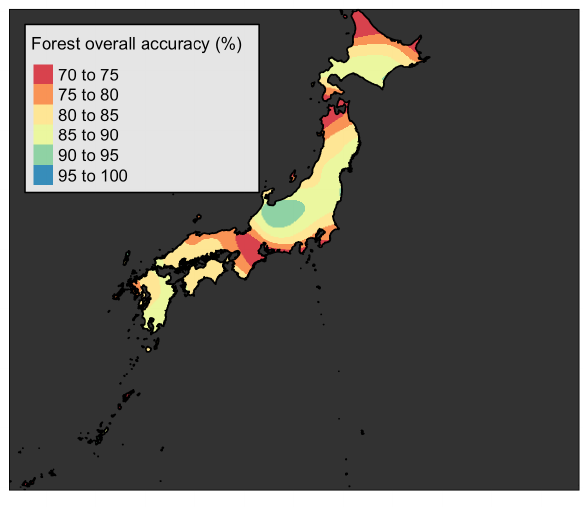
Figure 2. Geographically weighted forest overall accuracy. Maps of both GWFU and GWFP shown in Figure 3 and 4 demonstrate clear spatial variations of accuracy. The highest variation can be found in the EBF for both of the FU and the FP (the standard deviations are 25.3 and 30.5, respectively). Surfaces of accuracy in some areas in the Japanese territory lacks due to insufficient number of classification and reference sample points, implying that there is no distribution of the class found in such areas. Each map indicates potential spatial clusters of high / low accuracy. For example for the DNF, both FU and FP represent a cluster with high accuracy (over 90%) in the central mainland. It is reasonable to find highly accurate clusters in such regions as the DNF is distributed in cooler regions such as Hokkaido and high-elevated mountainous areas in Japan (mostly found in the central Japan) (Oshida et al., 2009). In the meantime, the DNF are relatively less found in other areas, meaning the